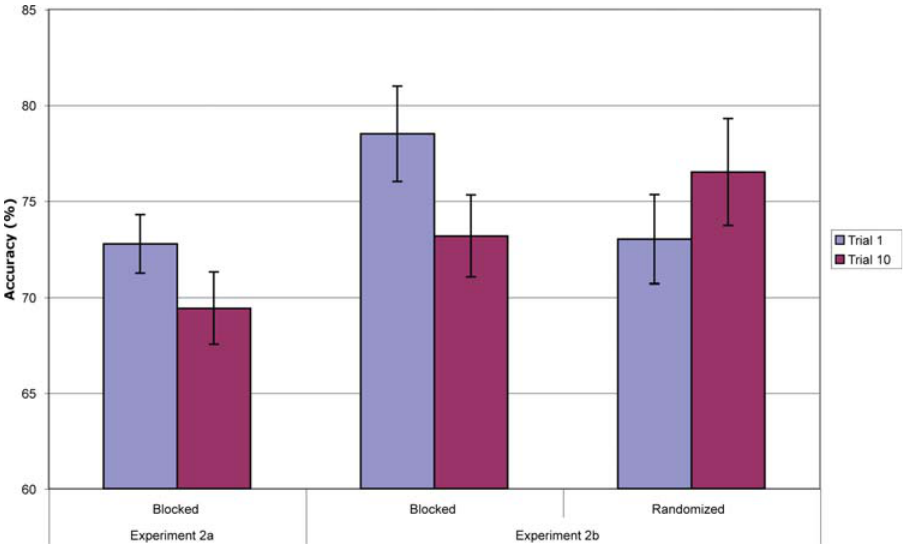
Figure 4. Accuracy (with standard errors) for the first trial (low proactive interference) and last trial (high proactive interference) of each mini-block in Experiments 2a and 2b (note that the in Experiment 2b, the first and tenth trials are both low proactive interference trials).